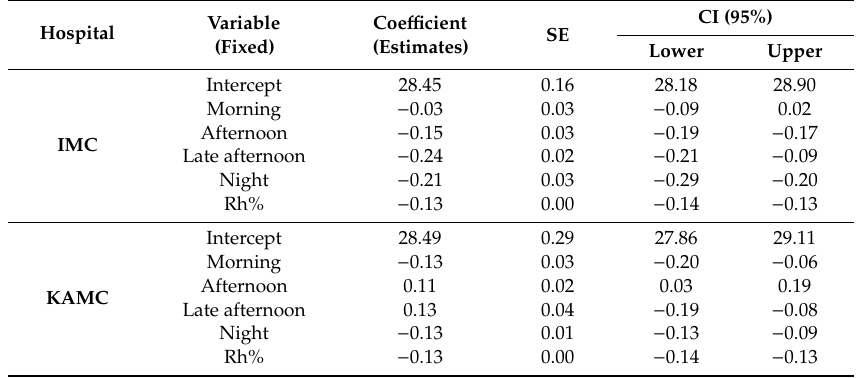
Table 6. Results of indoor temperature predicted by the mixed e ff ects model in patient rooms at IMC and KAMC (SE: standard errors, CI: confidence interval at